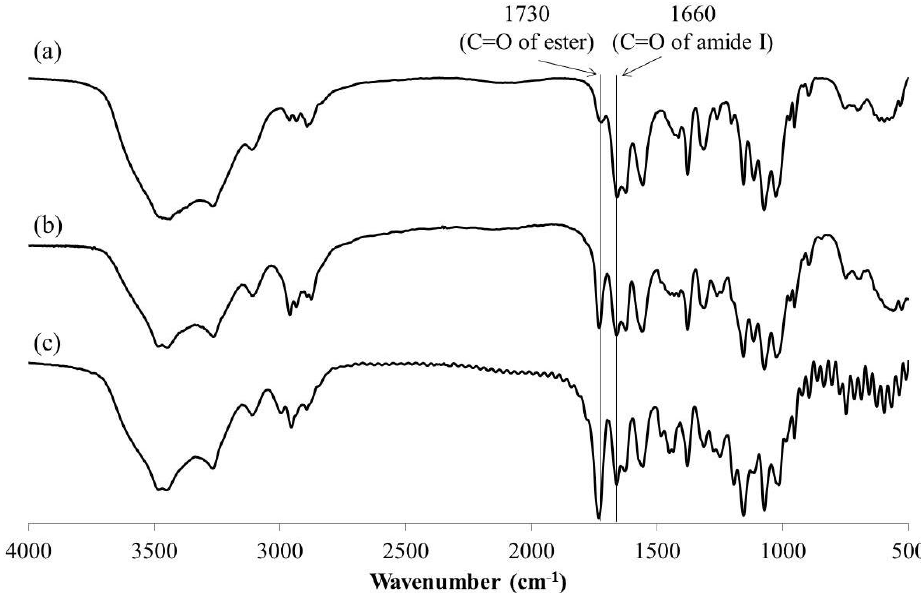
Figure 3. IR spectra of CNF macroinitiator ( a ) and CNF- g -PMMA films (MMA; 5 equiv. ( b ); 10 equiv. ( c